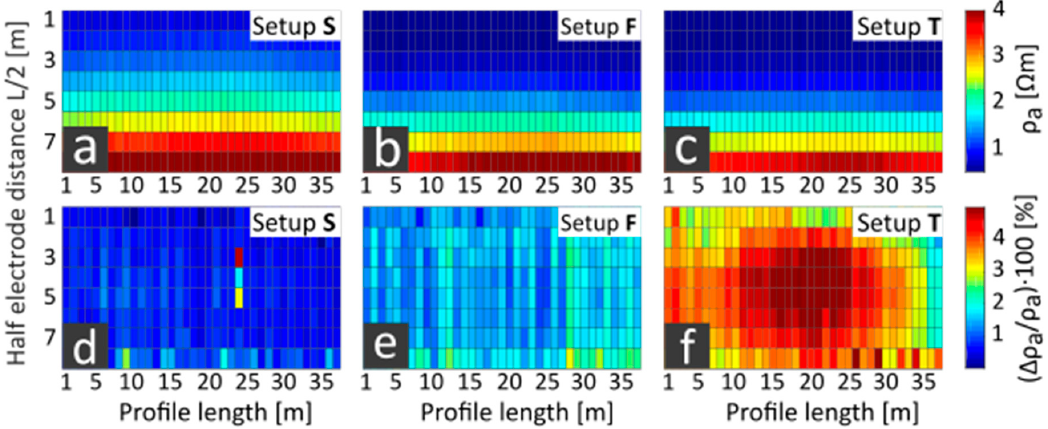
Figure 6. ( a – c ) Mean values and ( d – f ) relative standard deviations from repeated measurements for eight electrode pairs ( y -axis) along the profile ( x -axis). Left column: setup S (submerged), center column: setup F (floating), right column: setup T (towed). Table 2. Summary of relative standard deviations for different measurement setups arithmetically averaged from 40 measurement positions for the most affected electrode layout (L/2 (m), see Table 1). Additional aspects such as the bin size, the towing direction depending on the wind and the measurement cycle length are listed.